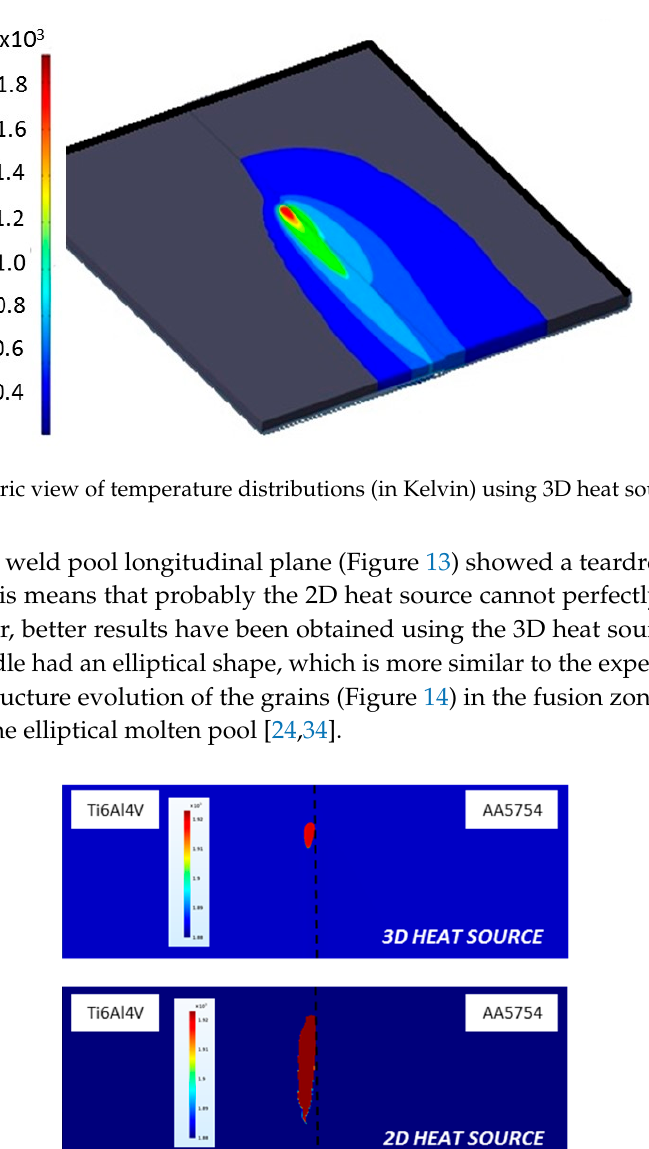
Figure 11. Isometric view of temperature distributions (in Kelvin) using 2D heat source modelling.